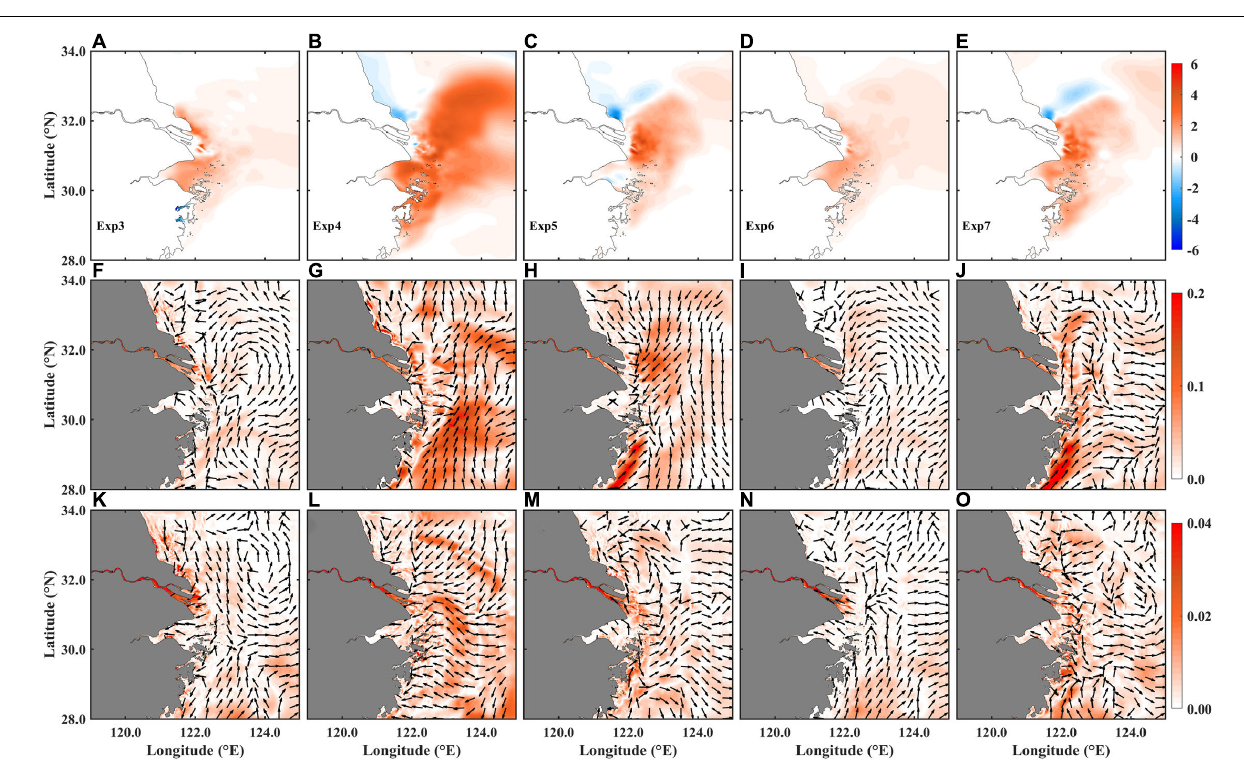
FIGURE 13 | The difference of (A–E) surface salinity, (F–J) surface current, and (K–O) bottom current (unit: ms − 1 ) averaged from July 11 to 19, 2006 in (A,F,K) Exp1 (CR) –Exp3 (NoCWCBS), (B,G,L) Exp1–Exp4 (NoFormDrag), (C,H,M) Exp1–Exp5 (NoWDinTKE), (D,I,N) Exp1–Exp6 (NoWRS), and (E,J,O) Exp1–Exp7 (NoCARWE). Color indicates magnitude and arrows for